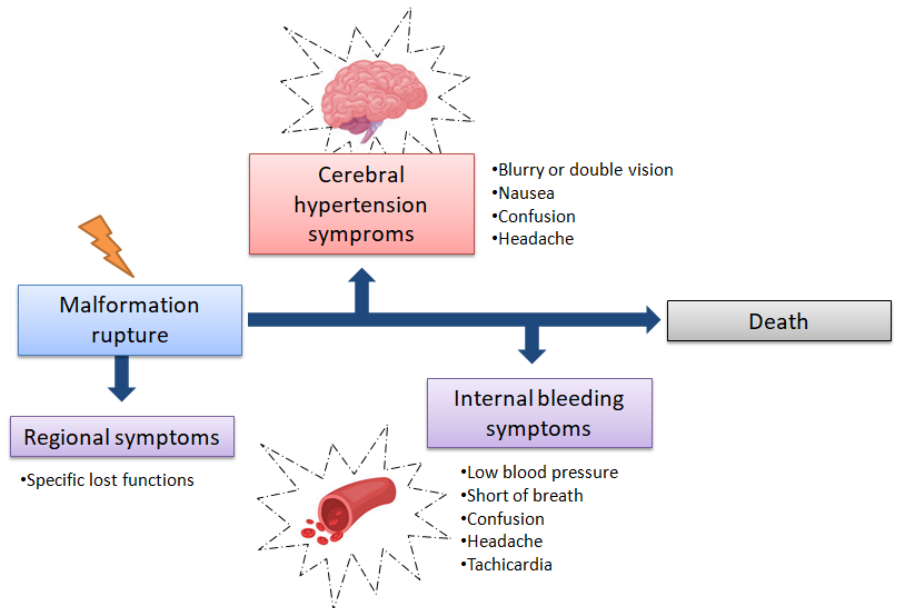
Figure 7. As time passes, the first symptoms of a vessel malformation rupturing in the brain become less and less specific, passing from regional symptoms (based on malformation rupture location), to a more generic hypertension and bleeding symptoms. In such conditions the healthcare professional should view the symptoms as a whole, performing specific diagnostic procedures as soon as possible to identify the localization of the rupture.